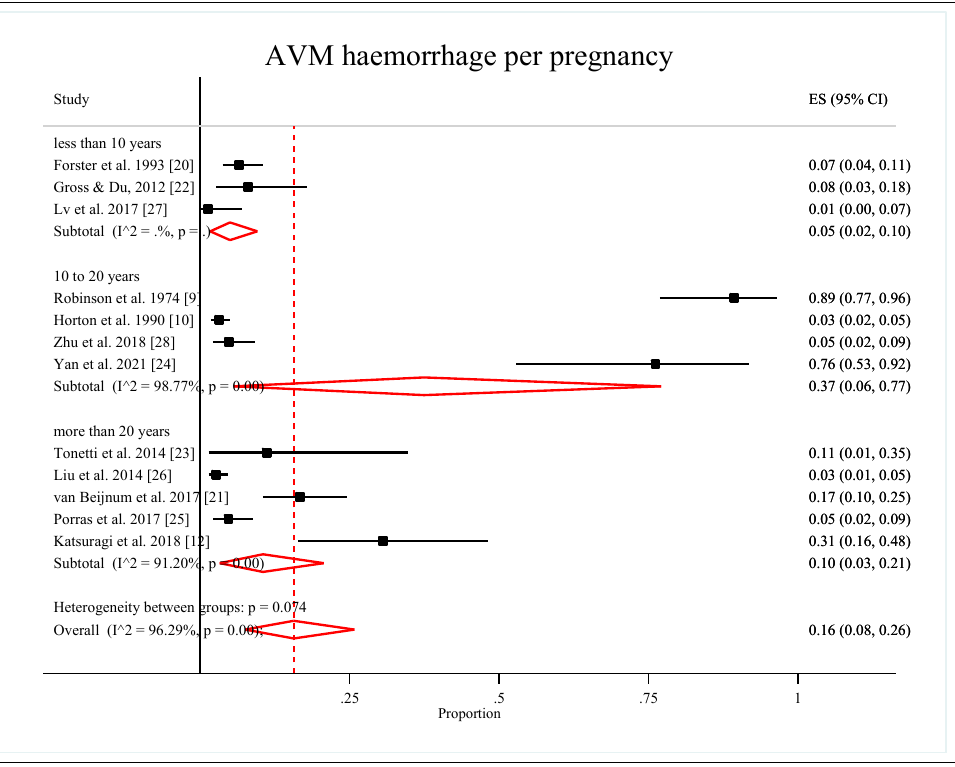
Figure 5. Forest plot of the pooled proportion of AVM hemorrhage per pregnancy by study duration [9,10,12,20–28].